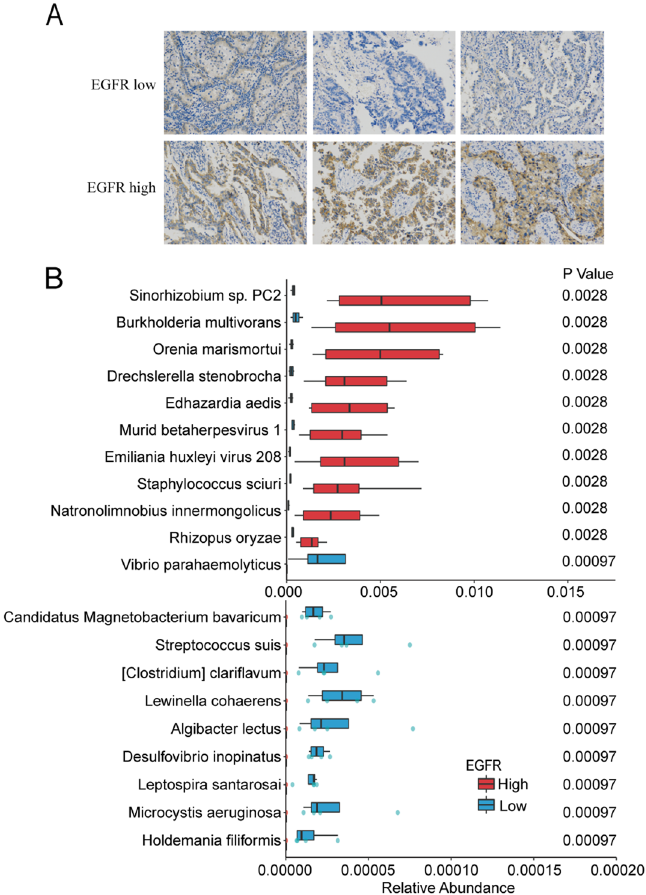
Figure 5. EGFR expression related microbiota composition in NSCLC patients. Representative images of the immunohistochemical detection of EGFR ( A ). Magnification: ×100. ( B ) The differential species in bronchoscopy samples between EGFR high patients and EGFR low patients were identified by Wilcoxon rank- sum test (p <